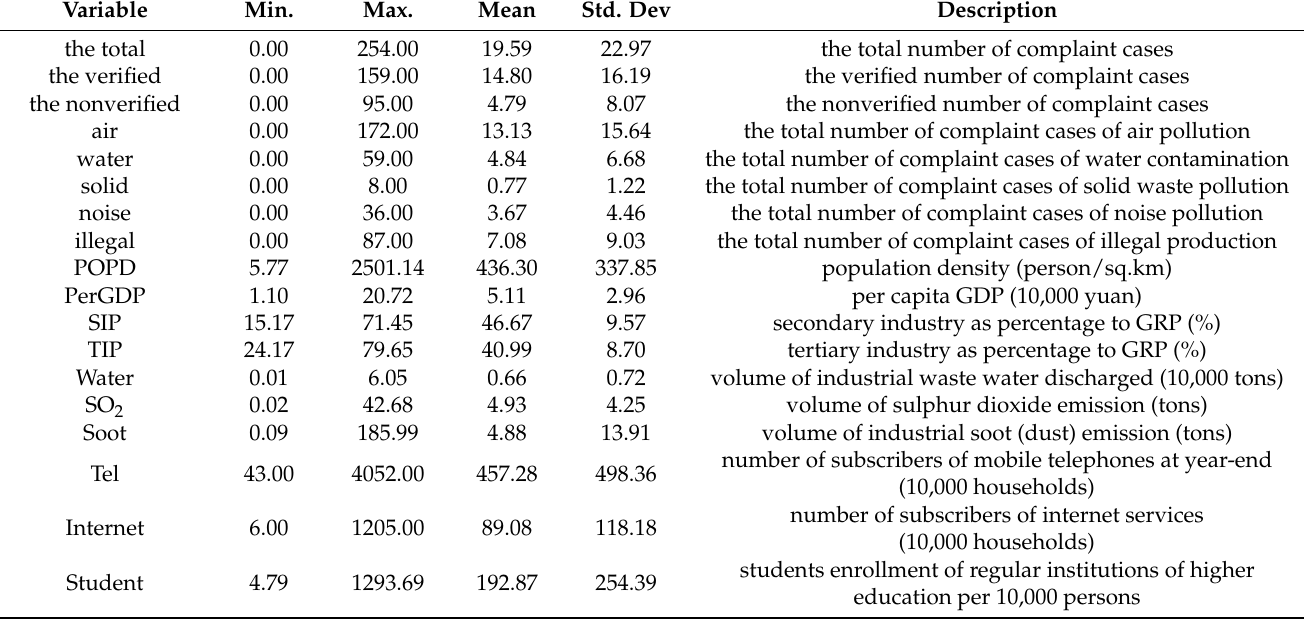
Table 2. Descriptive statistics of selected variables for 286 prefecture-level cities.